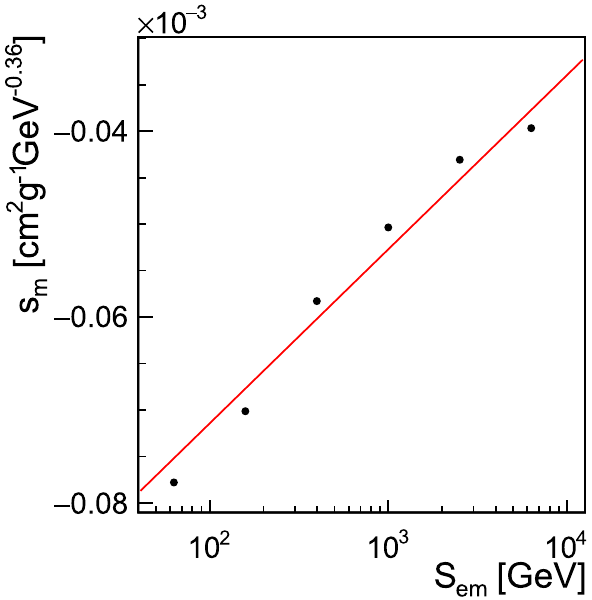
Fig. 14 Correlation of the slope s m of the m calibration lines repre- sented in Fig. 13 as a function of S em